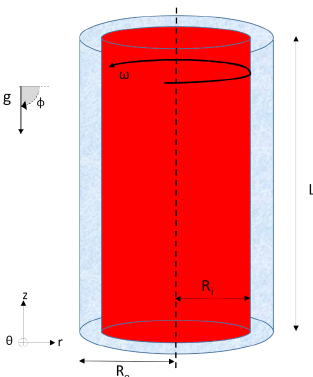
Figure 1. Position of the problem: two concentric cylindrical surfaces of inner and external radius, R i and R e , and of length, L , are inclined at an angle ϕ with the gravity. The rotation can be exerted from the inner (drawn here) or from the external cylinder at an angular velocity, ω . The heat gradient, ∂ T / ∂ r , can be imposed from any wall surface (the inner cylinder is chosen here), while the fluid motion is flowing into the gap, e = Re − Ri